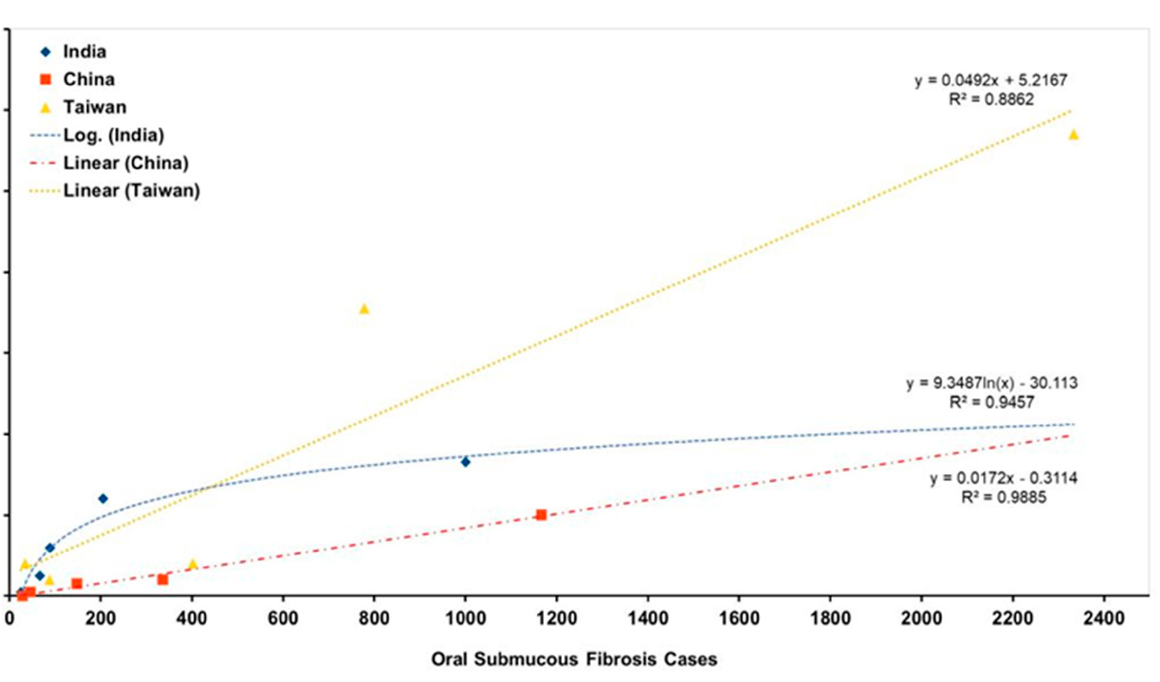
Figure 3. Comparison of cohort size and rate of malignant transformation of OSF as reported per study. Linear regression analysis for all data sets.